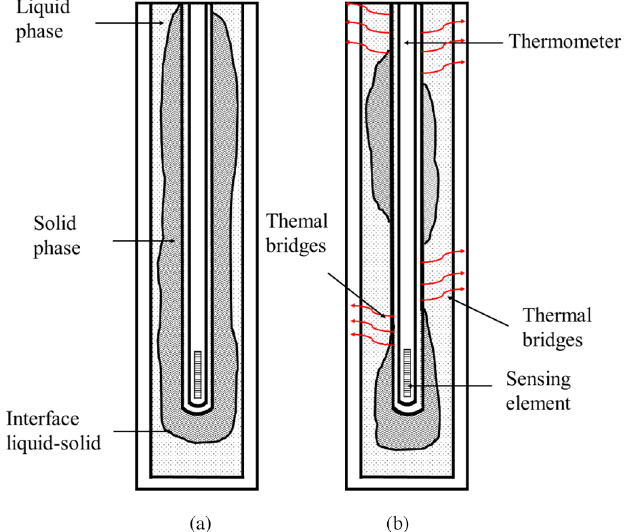
Fig. 3. Representation of thermal effects in a fi xed-point cell. (a) Proper liquid – solid interface. (b) Discontinuous liquid – solid interface.